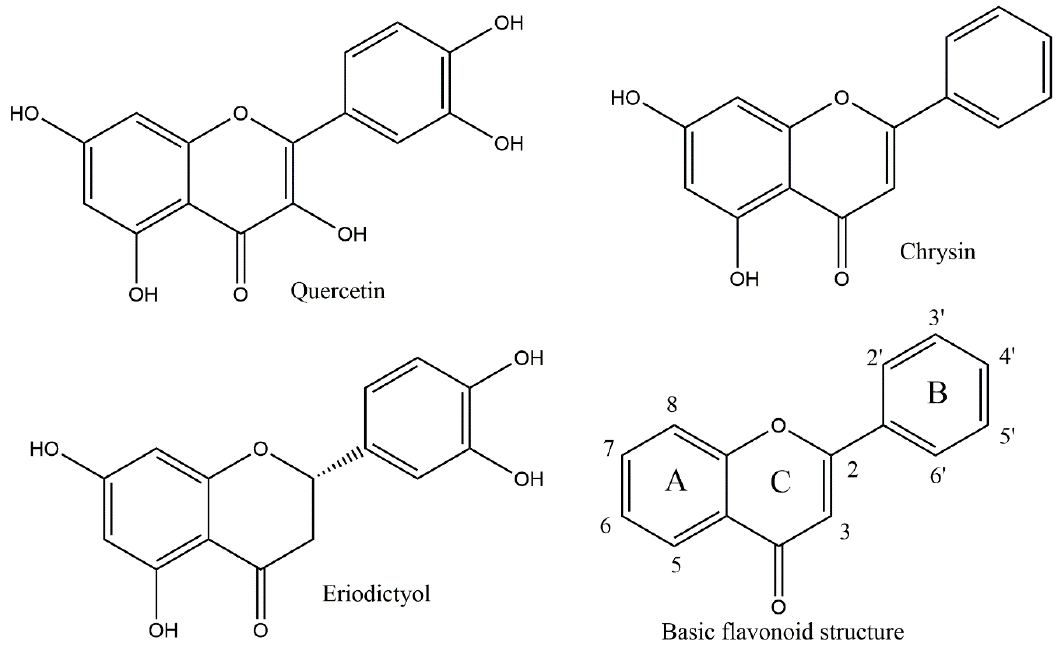
Figure 6. Flavonoids studied.